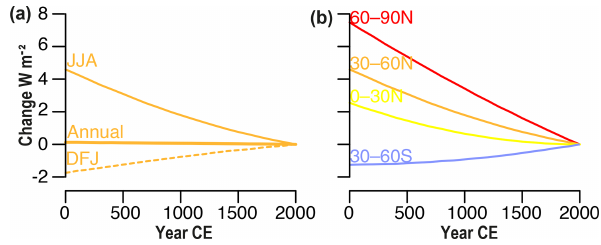
Figure 3. (a) June–August, December–February, and annual in- solation changes at 30–60 ◦ N relative to 2000 CE and (b) June– August insolation changes at different latitudinal bands (Laskar et al.,